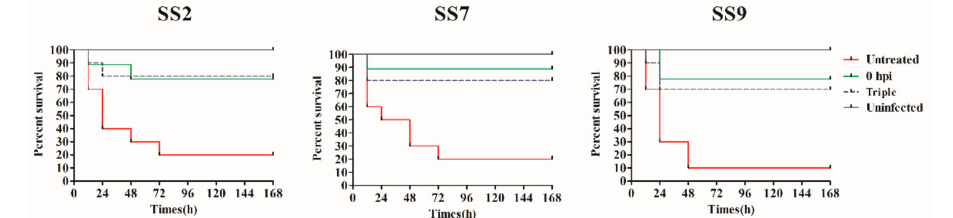
Figure 4. Survival curves of mice infected with S. suis and treated with Ply5218. A lethal dose (5 × 10 8 CFU / mouse) of SS2, SS7 or SS9 was injected into the abdominal cavities of the mice, and Ply5218 / PBS on the other side. In one group, Ply5218 was administrated immediately (0 h) post infection. In the other treatment group, mice were treated with Ply5218 at 6, 24, and 48 h post infection (triple treatment group). The infected mice treated with phosphate-bu ff ered saline (PBS) served as an untreated group. The uninfected mice treated with Ply5218 served as an uninfected group. hpi: hours post